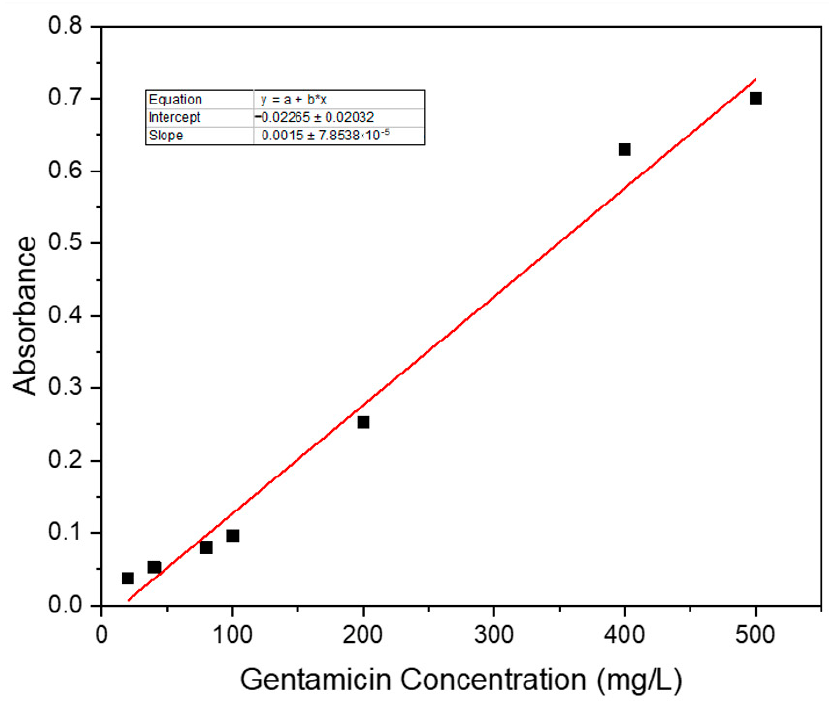
Figure 10. Standard calibration curve for gentamicin sulphate.